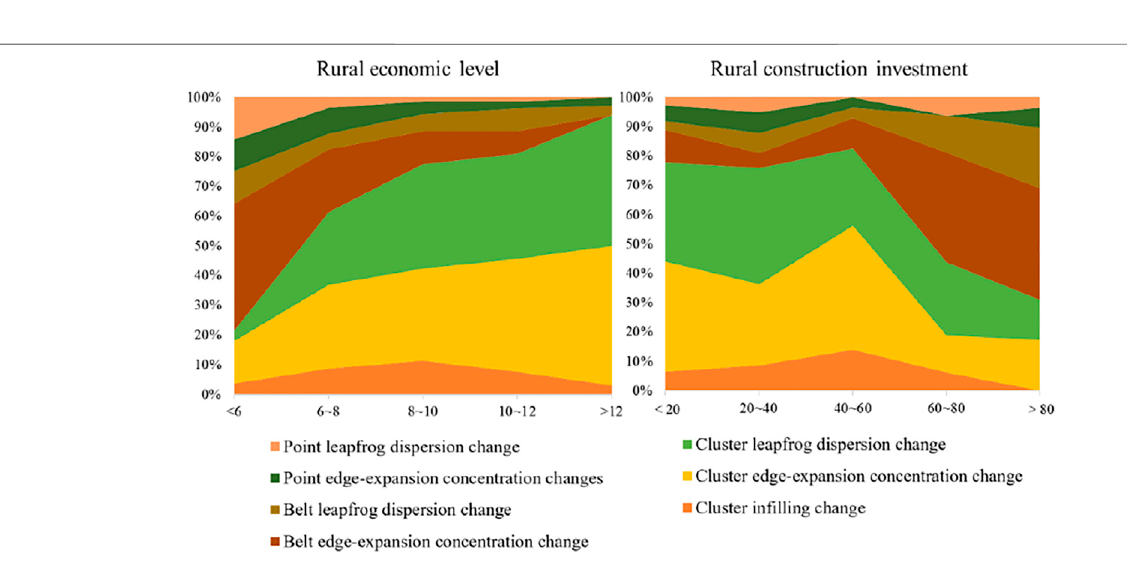
FIGURE 13 | Distribution characteristics of the dynamic spatial pattern of RRL under the economic-political